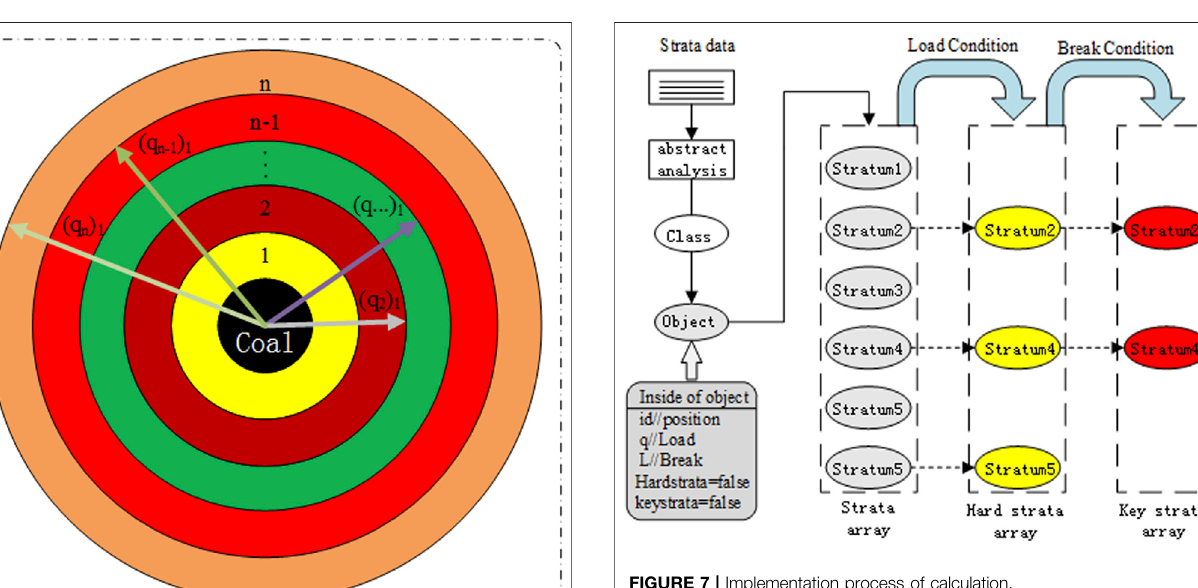
FIGURE 7 | Implementation process of